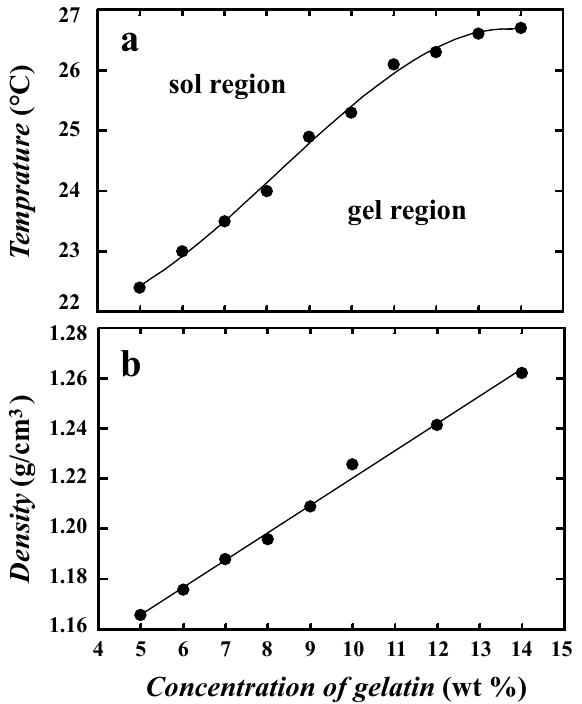
Figure 2. ( a ) Dependence of the sol-gel transition temperature on concentration. ( b ) Dependence of the density of the gelatin solution on concentration. We evaluated the sol-gel transition temperature using a tube inversion